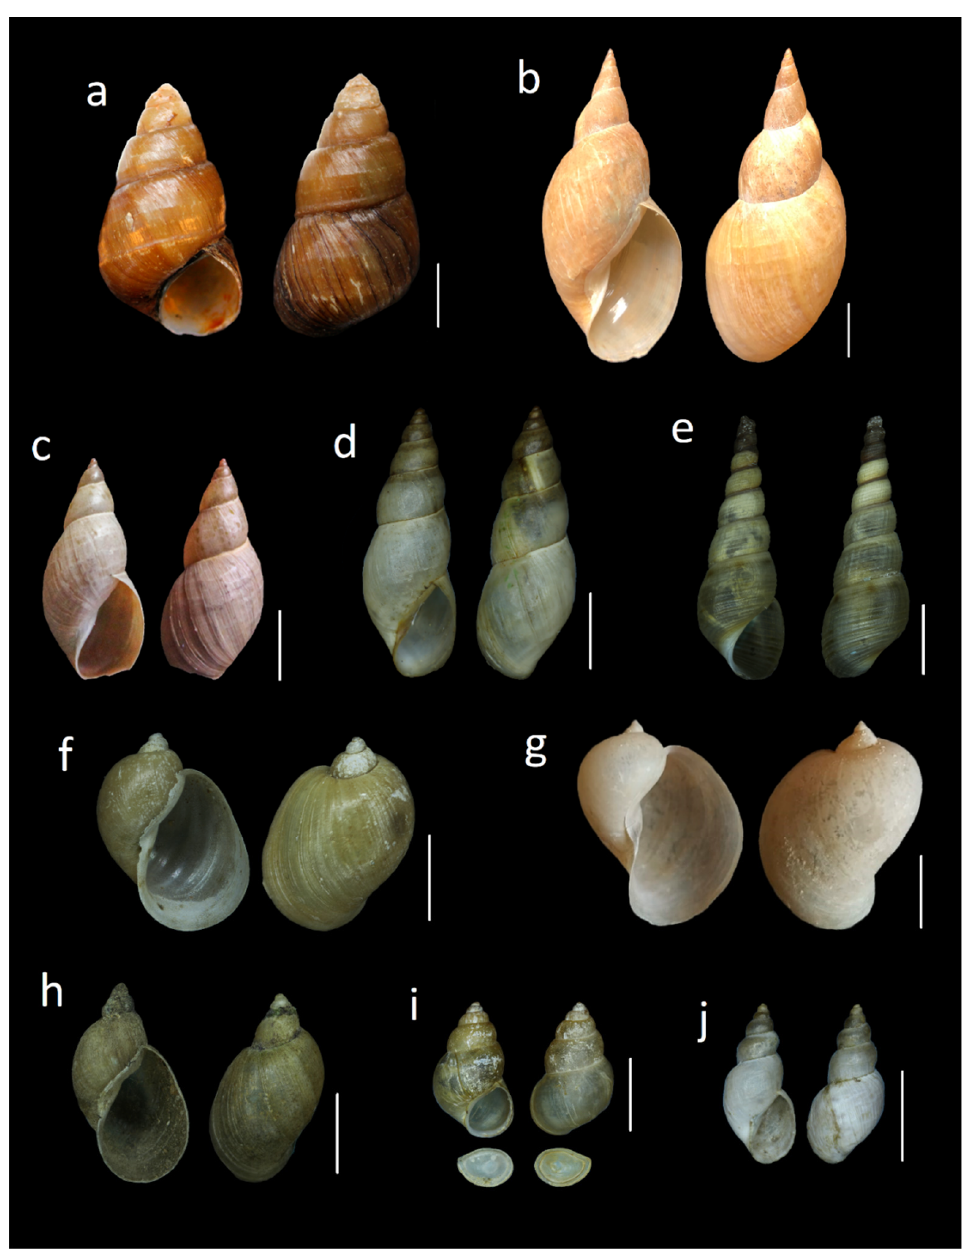
Figure 5. Intermediate freshwater gastropod hosts of trematodes in Asturias. ( a ) Sinotaia cf. quadrata (Nora River-Oviedo), ( b ) Lymnaea stagnalis (Villanueva de Oscos pond), ( c ) Stagnicola cf. palustris (spring in Lugones-Siero), ( d ) Omphiscola glabra (temporary pond in Avil é s), ( e ) Melanoides tuberculata (Nora River-Oviedo), ( f ) Ampullaceana balthica (Trubia River-Oviedo), ( g ) Radix auricularia (Trubia River-Oviedo), ( h ) Radix cf. labiata (Bascones River-Grado), ( i ) Bithynia tentaculata (Embalse de Valduno–Las Regueras), ( j ) Galba truncatula (Bascones River-Grado). All scale bars 1